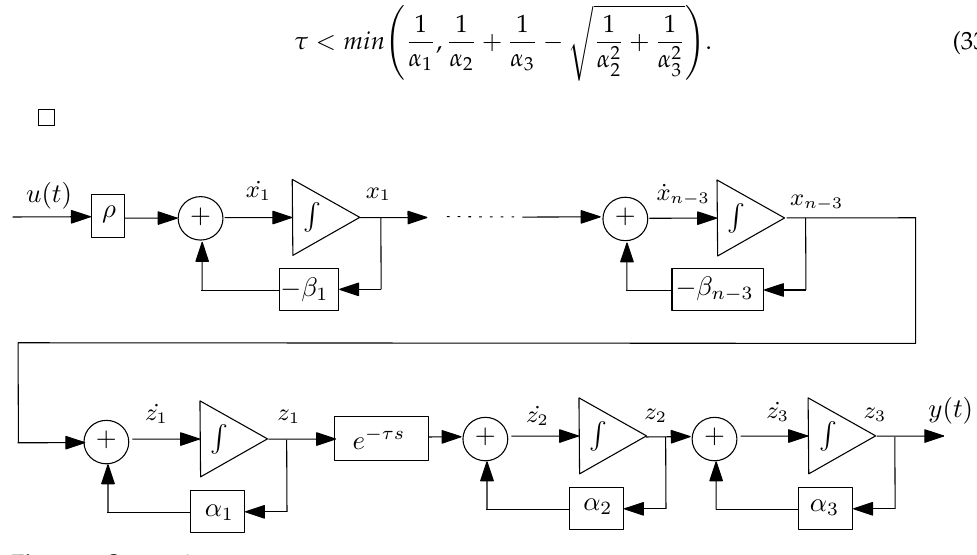
Figure 4. System in state